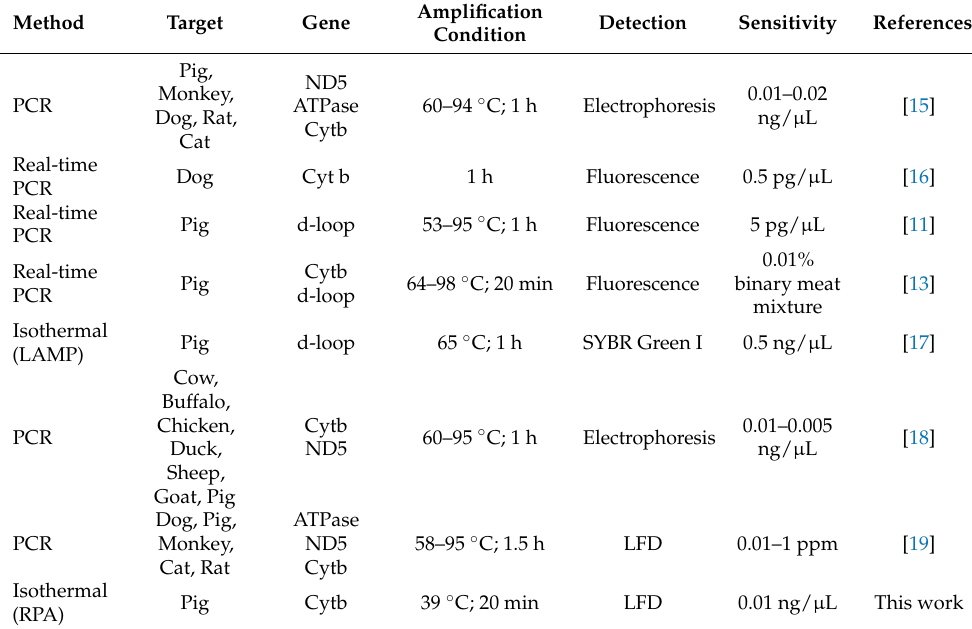
Table 1. Application of DNA-based method for detection of animals’ source in